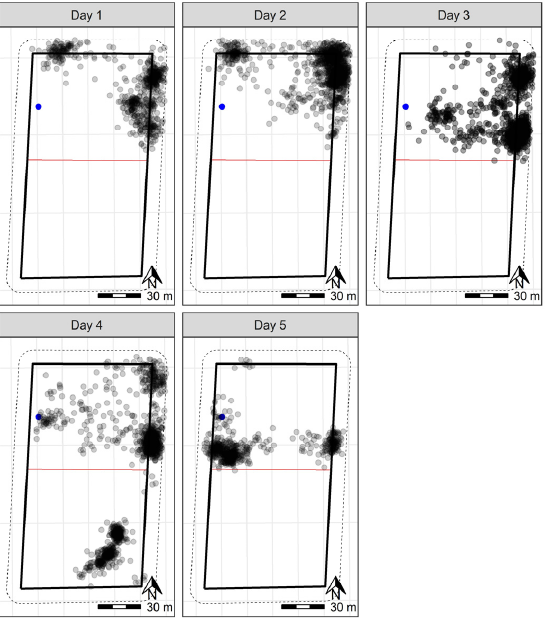
Figure 4. GPS plots per day for 10 sheep at Lameroo, with the water point within the inclusion zone